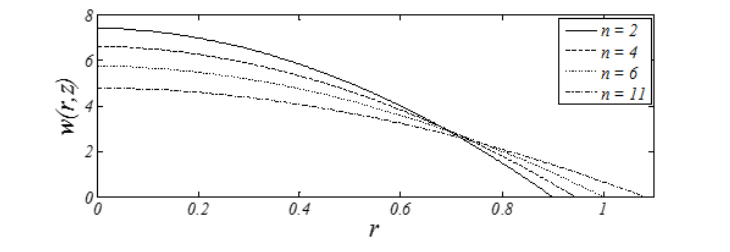
Fig. 6 Velocity variation for F=2, δ =0.4, a=0.2, b=0.4, m=1.1.